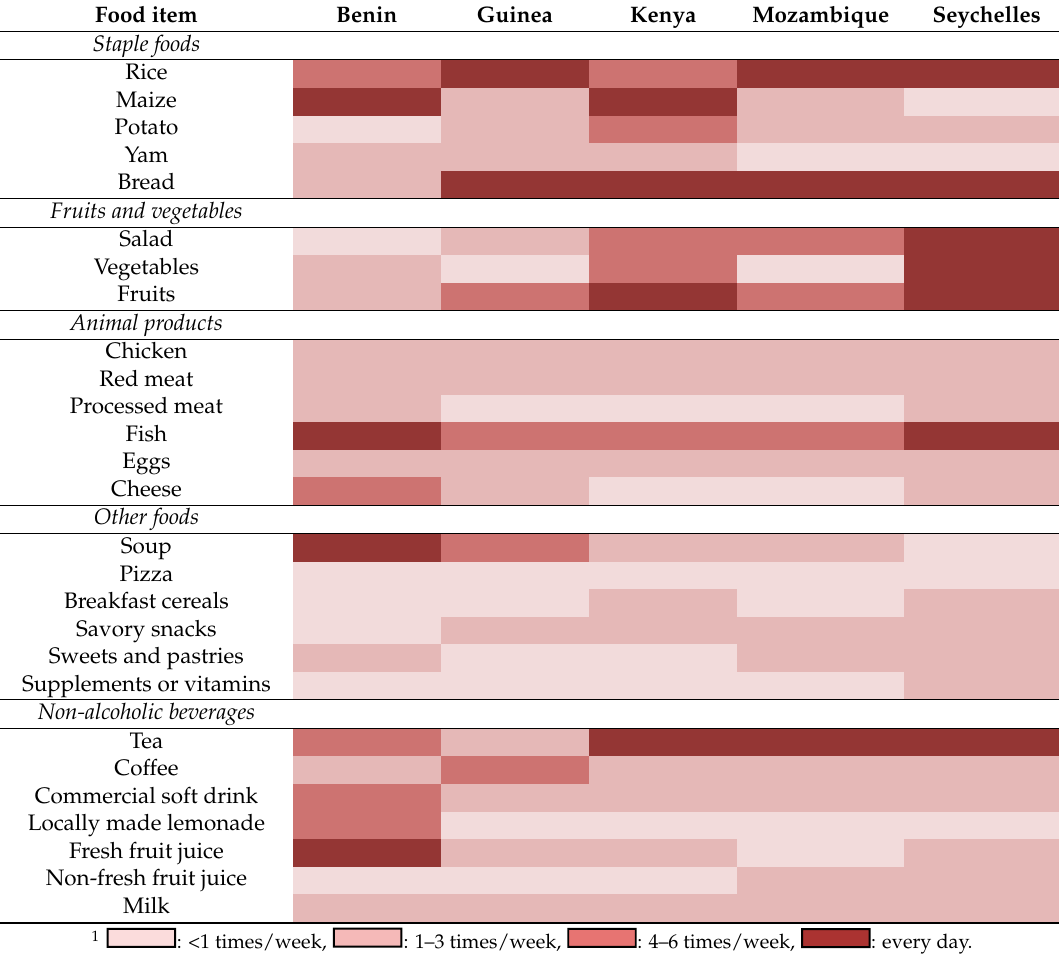
Table 2. Consumption of selected food items according to country 1 .